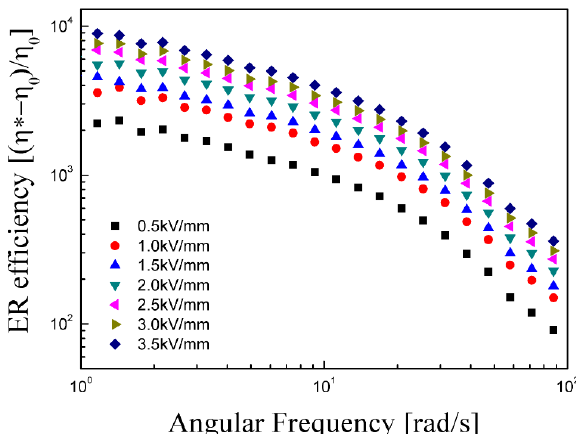
Figure 8. ER efficiency as a function of angular frequency of PMMA-PNMA particle-based ER fluid.